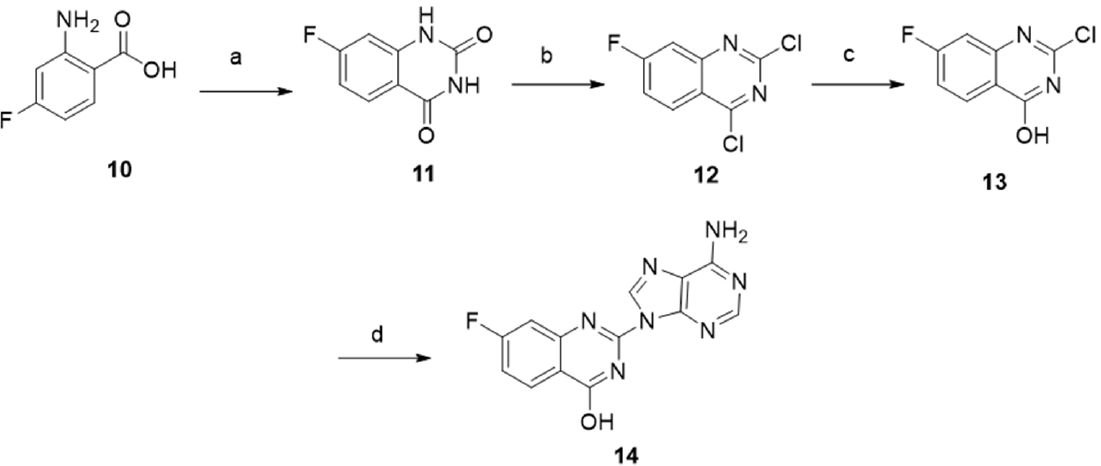
Figure 6. Synthesis of compound 14 . Reagents and conditions: (a) urea, 150 °C, 7 h, (b) POCl 3 , N, N -dimethylaniline, 110 °C, 7 h, (c) sodium hydroxide solution (NaOH 2%), 60 °C, 6 h, (d) adenine, cesium carbonate (Cs 2 CO 3 ), silica gel, inert atmosphere, 130 °C, 24 h.